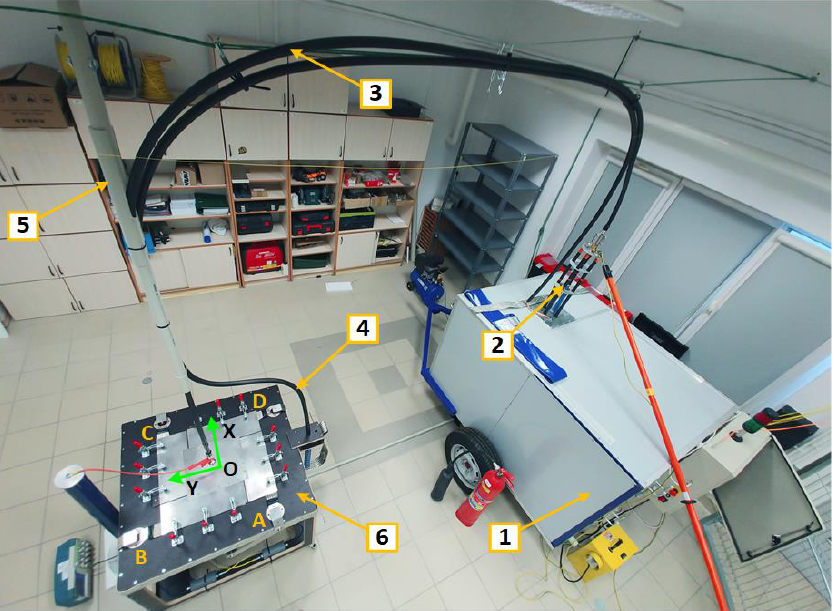
Figure 1. The view of the measurement system before the first operation: 1—impulse current generator, 2—high voltage output, 3—high-voltage cable, 4—return wire, 5—insulated ceiling holder, 6—test bench.